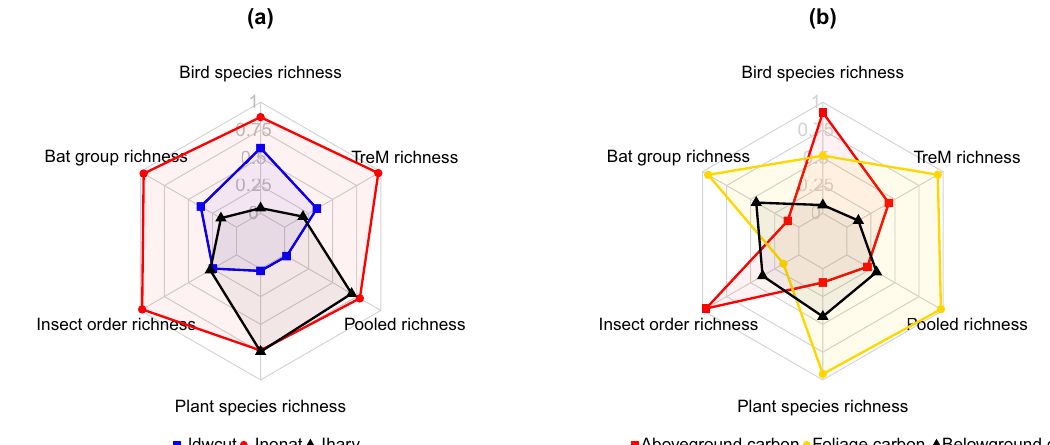
Figure 2. Scaled relative importance of the three parts of the a) forest management intensity (Idwcut: volume ratio of harvesting-related deadwood vs. deadwood of natural origin, Inonat: Ratio of volume in non-native vs. native tree species , Iharv: Ratio of harvested tree volume vs. maximum total stand volume) and b) three carbon pools (aboveground, foliage, and belowground) on the richness of four taxonomic groups, the pooled richness of those groups and richness of tree-related microhabitats. Relative importance ranges between 0 and 1. This graph was produced with R software and the fmsb package 46